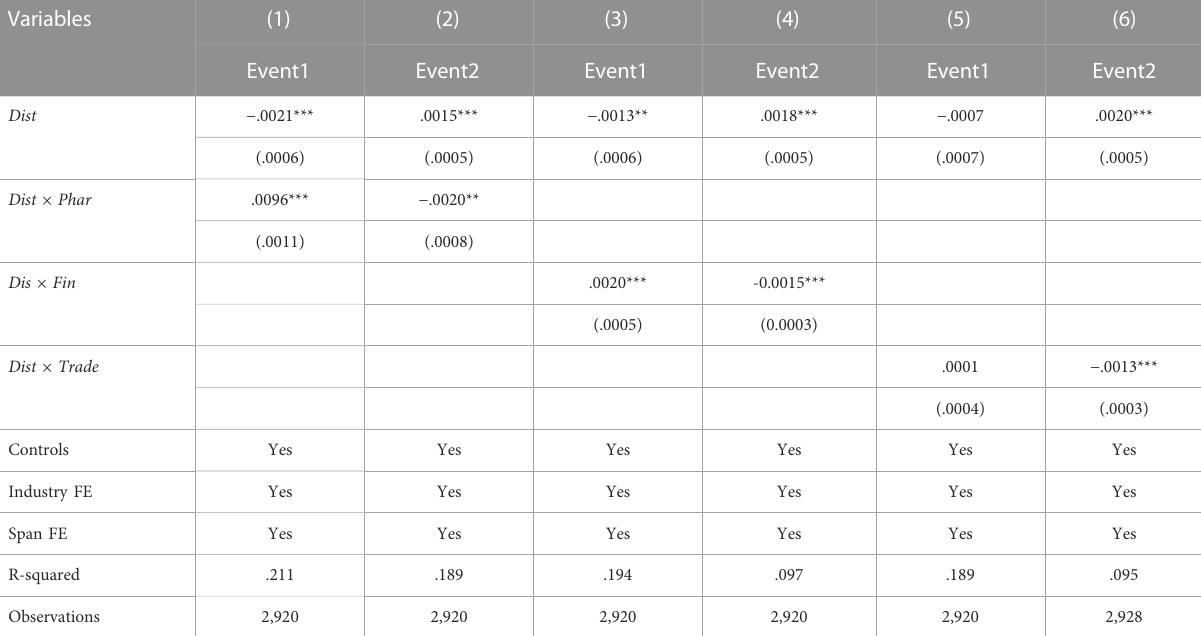
TABLE 8 Heterogeneity analysis: industry, level of fi nancial development and business type.